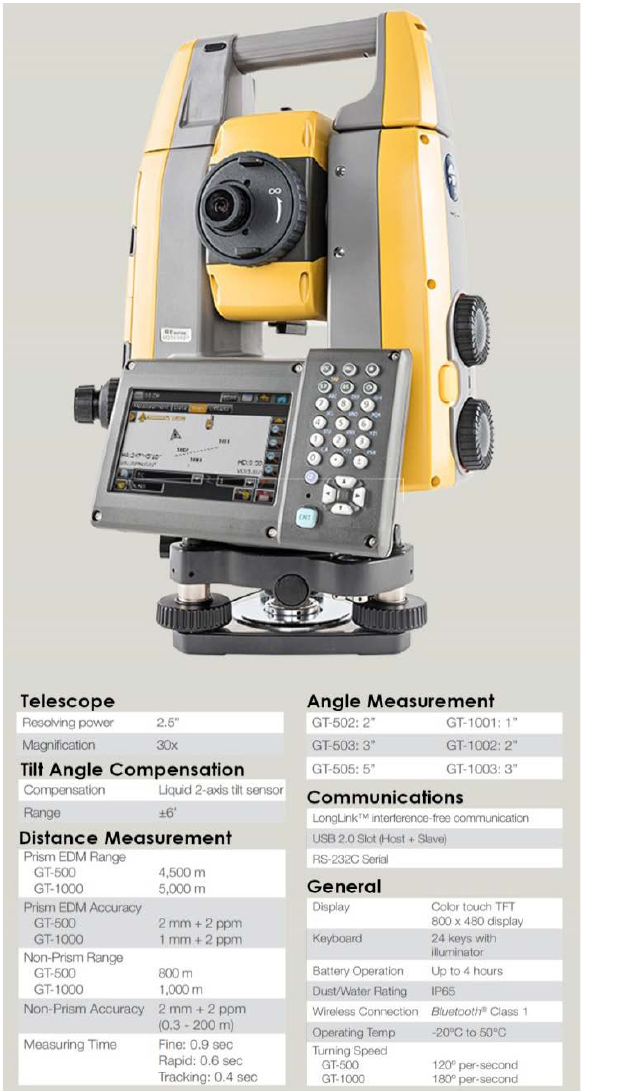
Figure 6: TopCon Total Station GT Series. Figure 7: Topcon GLS-2000 series Laser Scanner.